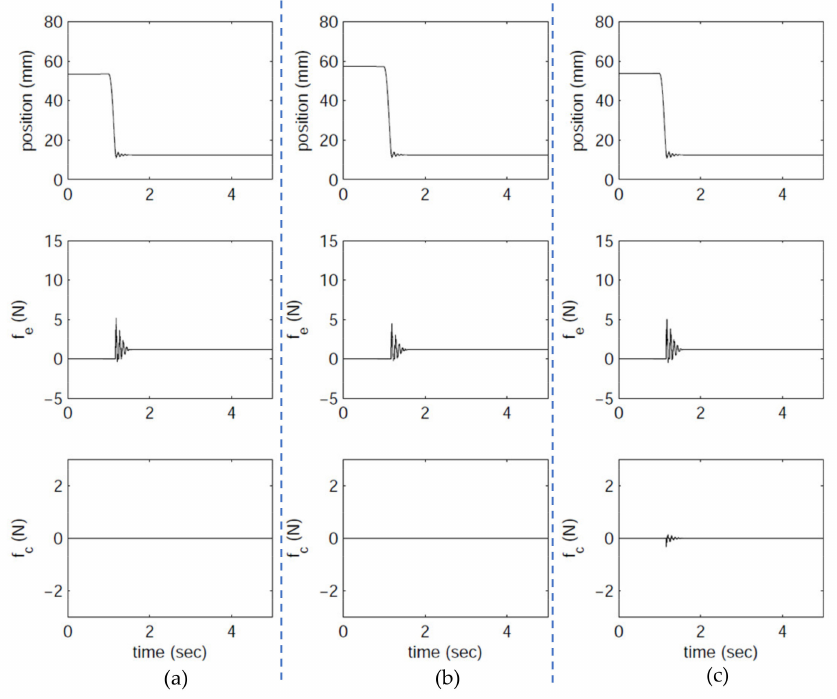
Figure 9. Experimental results at K = 2000 N/m, B = 5 Ns/m, α = − 1 Ns/m: ( a ) controller free, ( b ) the basic passivity controller, and ( c ) the impedance-passivity controller